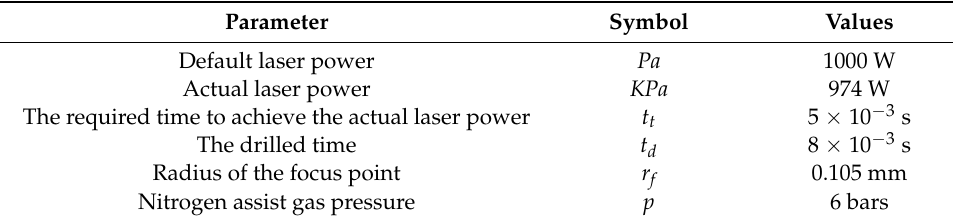
Table 1. Laser drilling conditions used in the experiment and simulation.